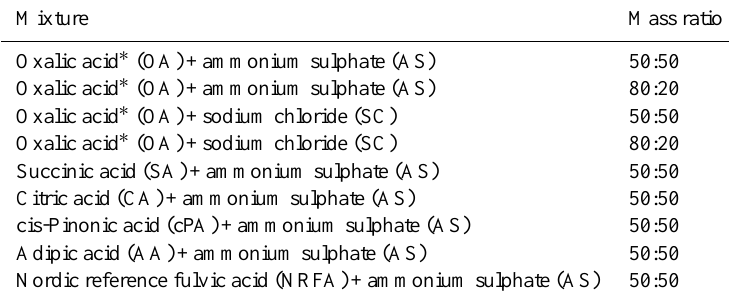
Table 1. Chemical composition of mixtures which have been used in experiments.